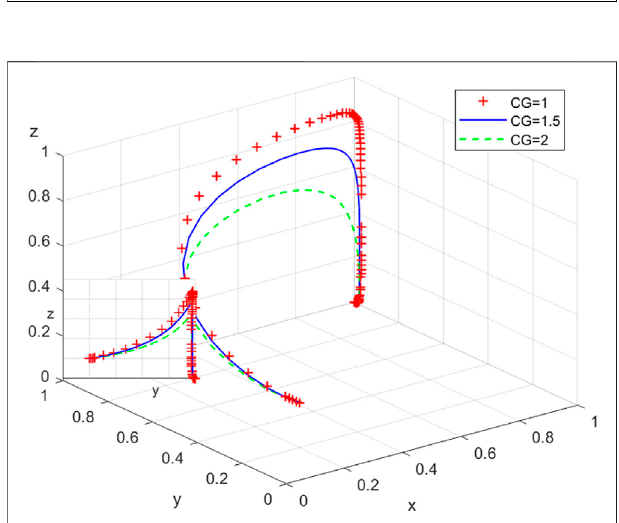
FIGURE 10 | Impact of the bene fi ts obtained by CP after successfully supervising MEs on the evolution track of the tripartite evolutionary game.